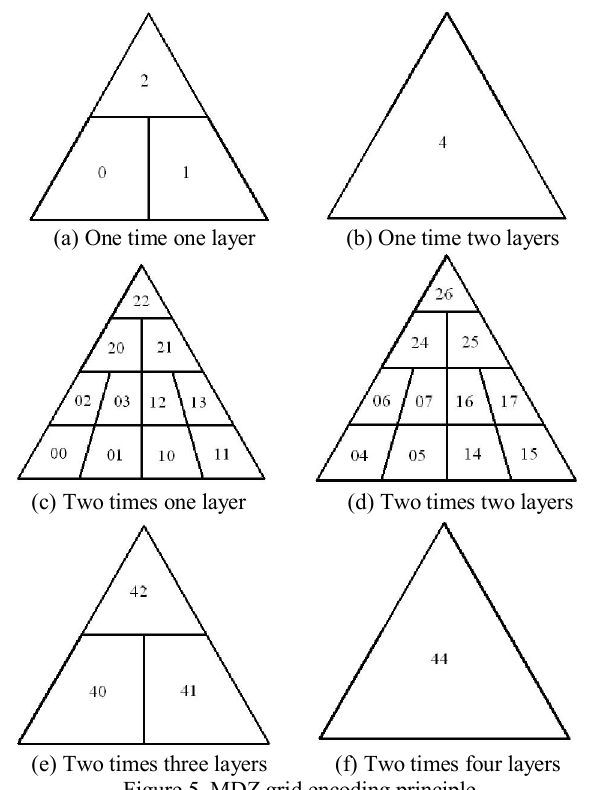
Figure 5. MDZ grid encoding